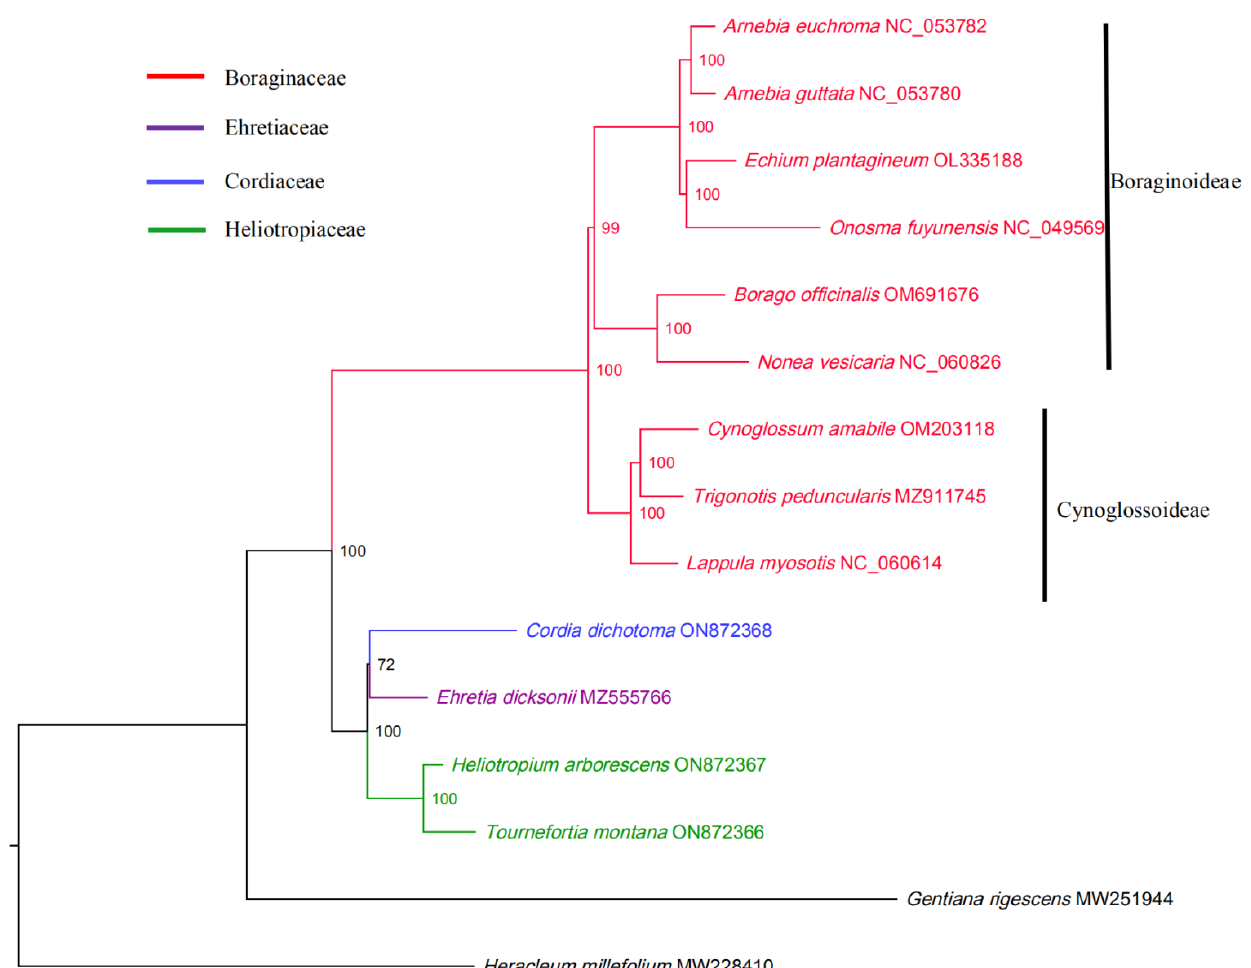
Figure 8. Phylogenetic analyses of the Boraginales species using the maximum likelihood (ML) method, based on 80 protein-coding genes .